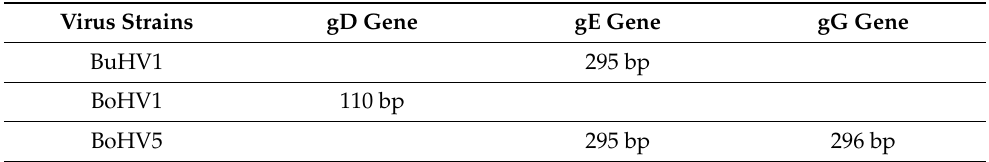
Figure 4 . Agarose gel electrophoresis of the amplified products obtained by using the primers for the portion of gG gene. The DNA marker in the first lane showed the first band at 50 bp, the second at 100 bp and the subsequent ones at 100 bp from each other. BoHV-1 was loaded in the second and third lanes, BuHV-1 in the fourth and fifth, BoHV-5 in the sixth and in the seventh and the eighth lane was the negative control (blank). Amplification products of 296 bp were observed for BoHV-5. Table 1. Summary table of the results obtained by using the PCR